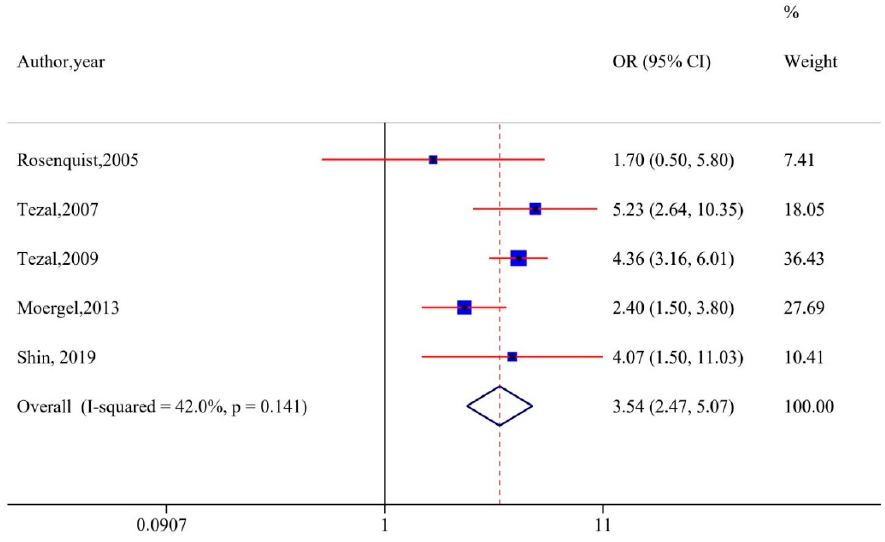
Figure 4. Subgroup analyses based on alveolar bone loss.